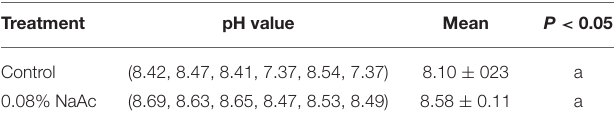
TABLE 1 | Comparison of the pH values of the treatments and control groups at the end of the cultivation cycle.